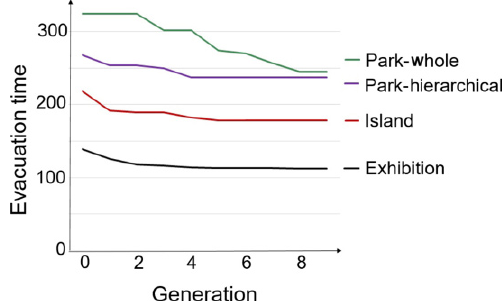
Fig. 6 Our system takes about eight generations to converge based on the evacuation time of the last agent.